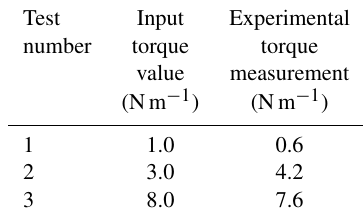
Table 2. Torque measurement results.